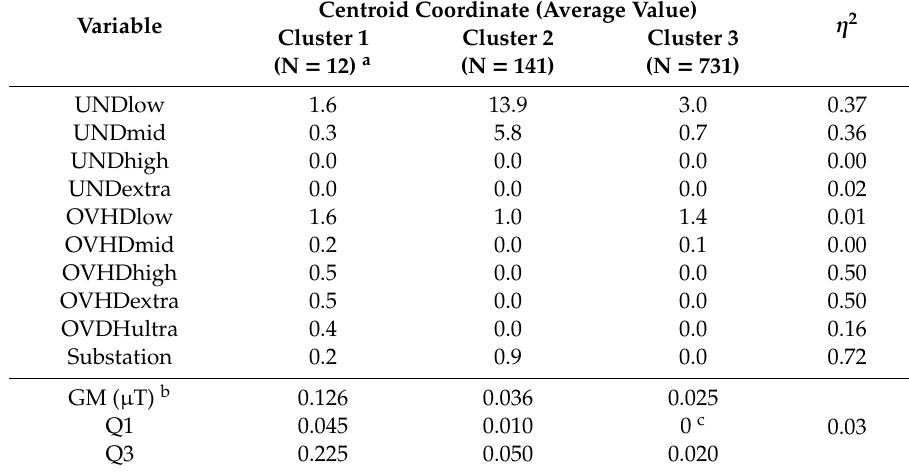
Table 2. Cluster model for the 50 Hz magnetic field exposure. The table displays the coordinates of the centroids for each of the 11 analyzed variables (from ‘UNDlow’ to ‘GM’) of the three clusters obtained from the analysis of the 50 Hz MF. Centroid coordinates are the average number of electric networks near the child home (for variables from ‘UNDlow’ to ‘Substation’) and the average GM in µ T within each cluster. The rightmost column is the correlation